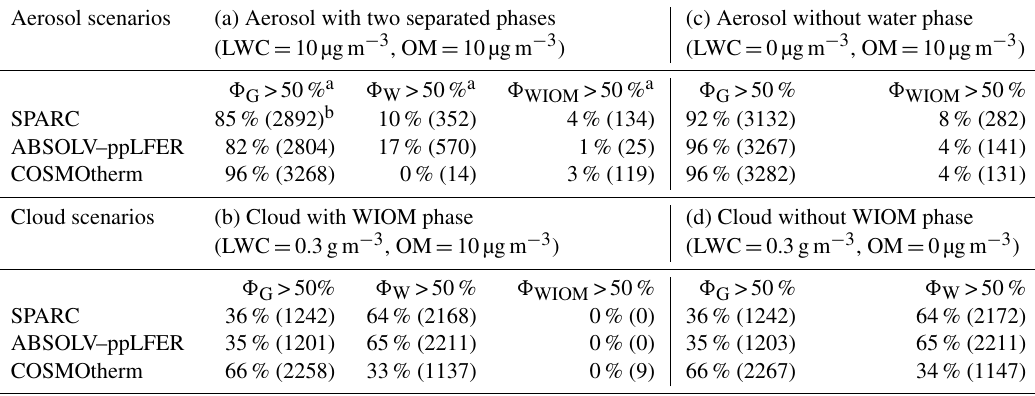
Table 2. Percentage and number of compounds with at least 50% in gas, water, or WIOM phase under different aerosol and cloud scenarios predicted with SPARC, ABSOLV–ppLFER, and COSMOtherm. The four scenarios a–d correspond to the scenarios in Fig. S12a–d in the